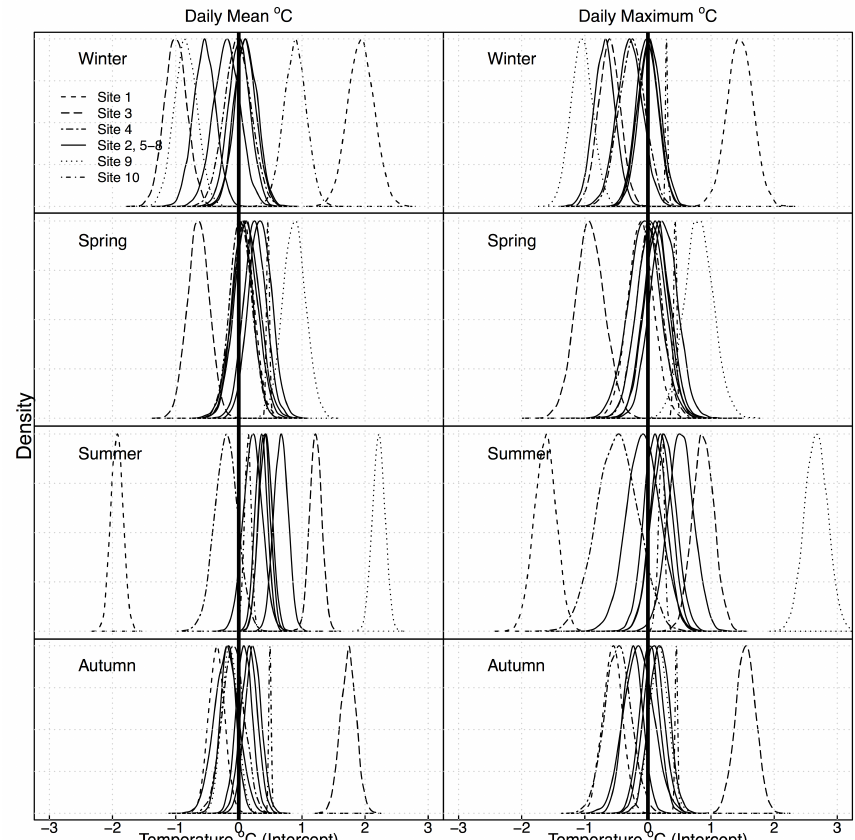
Figure 5. Posterior probability density functions of estimated intercept temperature ( ◦ C) from daily mean ( left ) and maximum ( right ) stream temperature Bayesian hierarchical regression with daily mean and maximum air temperature, respectively, for each season at each recording site. Mean daily and maximum stream temperature for each season was used as the baseline to calculate anomalies for seasonal mean daily and season mean daily maximum stream temperatures at each basin. An intercept = 0 ◦ C (dark vertical line) indicates that the mean daily T s at a basin is the same as the mean stream temperature for all basins combined for that season. Winter = DJF, Spring = MAM, Summer = JJA, Autumn =